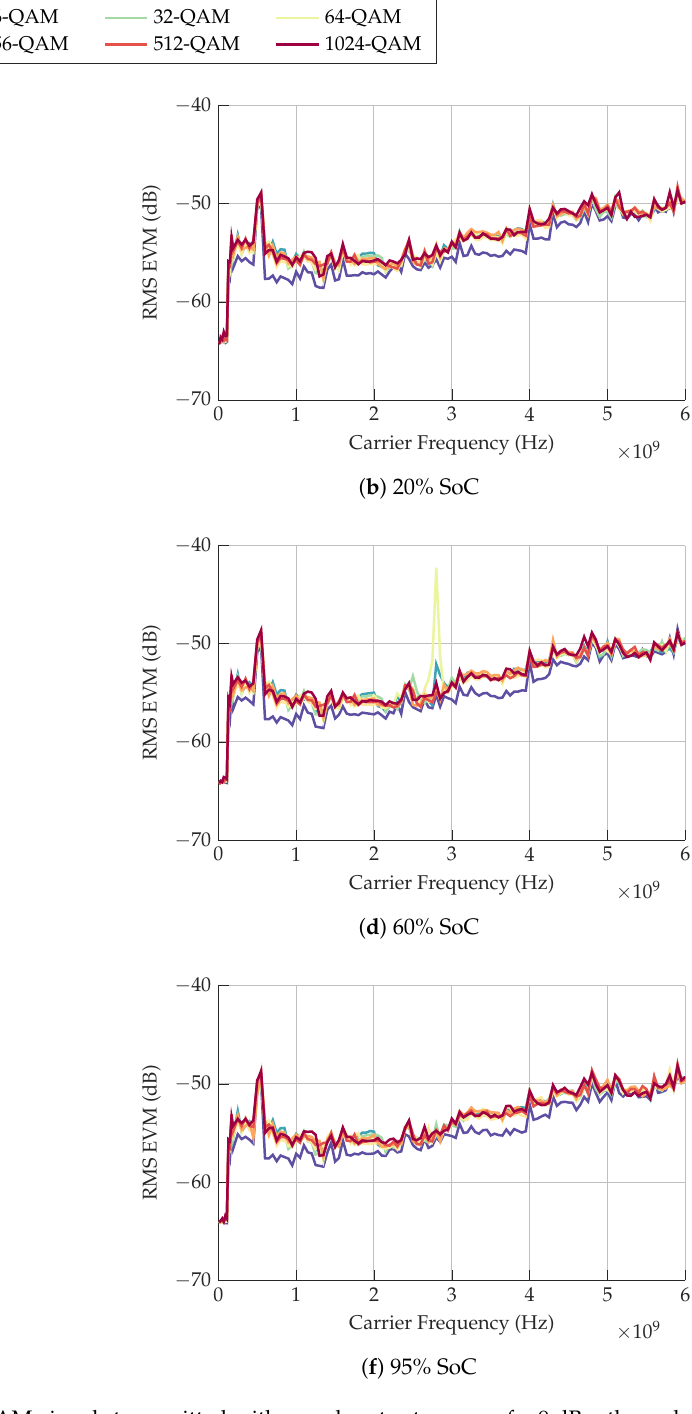
9 dBm through a −